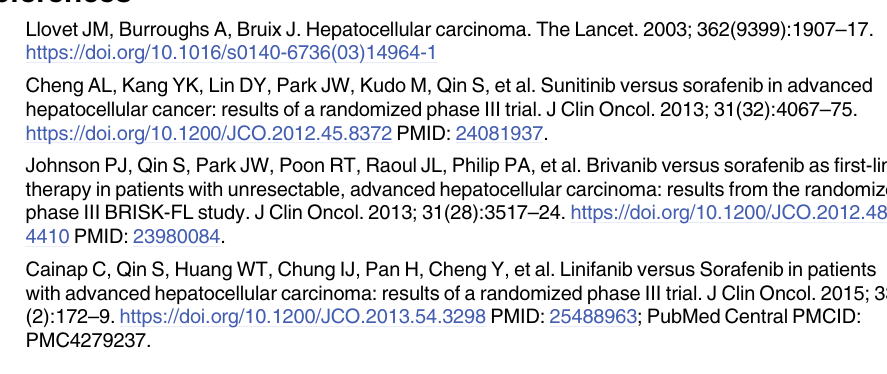
S2 Fig. The frequency of deteriorated Child-Pugh factors during the lenvatinib treatment. (TIF) S3 Fig. Association between baseline ANG2 and VEGF levels, changes in Child-Pugh score, and baseline Child-Pugh score. A. Correlation between baseline ANG2 or VEGF and changes in Child-Pugh score at 8 weeks post lenvatinib initiation. B. Comparison of baseline serum ANG2 and VEGF levels among patients with baseline Child-Pugh scores of 5, 6, and � 7. ANG2: angiopoietin 2, VEGF: vascular endothelial growth factor,C-P score: Child-Pugh score, Δ Child-Pugh score: Changes in Child-Pugh score at 8 weeks post lenvatinib initiation. (TIF) S4 Fig. Comparison of baseline serum ANG2 and VEGF levels between patients with or without object response. ANG2: angiopoietin 2, VEGF: vascular endothelial growth factor, CR: complete response, PR: partial response, SD: stable disease, PD: progressive disease.